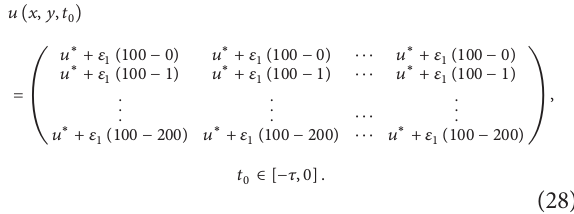
, 𝑑 ) = (0.08, 0.89, 0.37) , (b) (e) (𝑑,𝑑 21 22